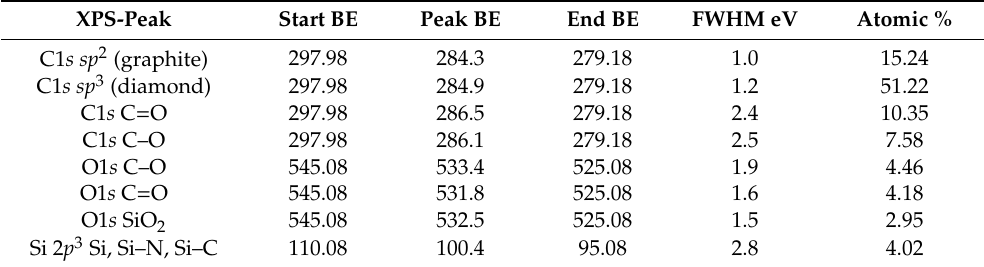
Table 5. Results of f-analysis software interpretation: composition and energy characteristics of DLC peaks (with (CrAlSi)N